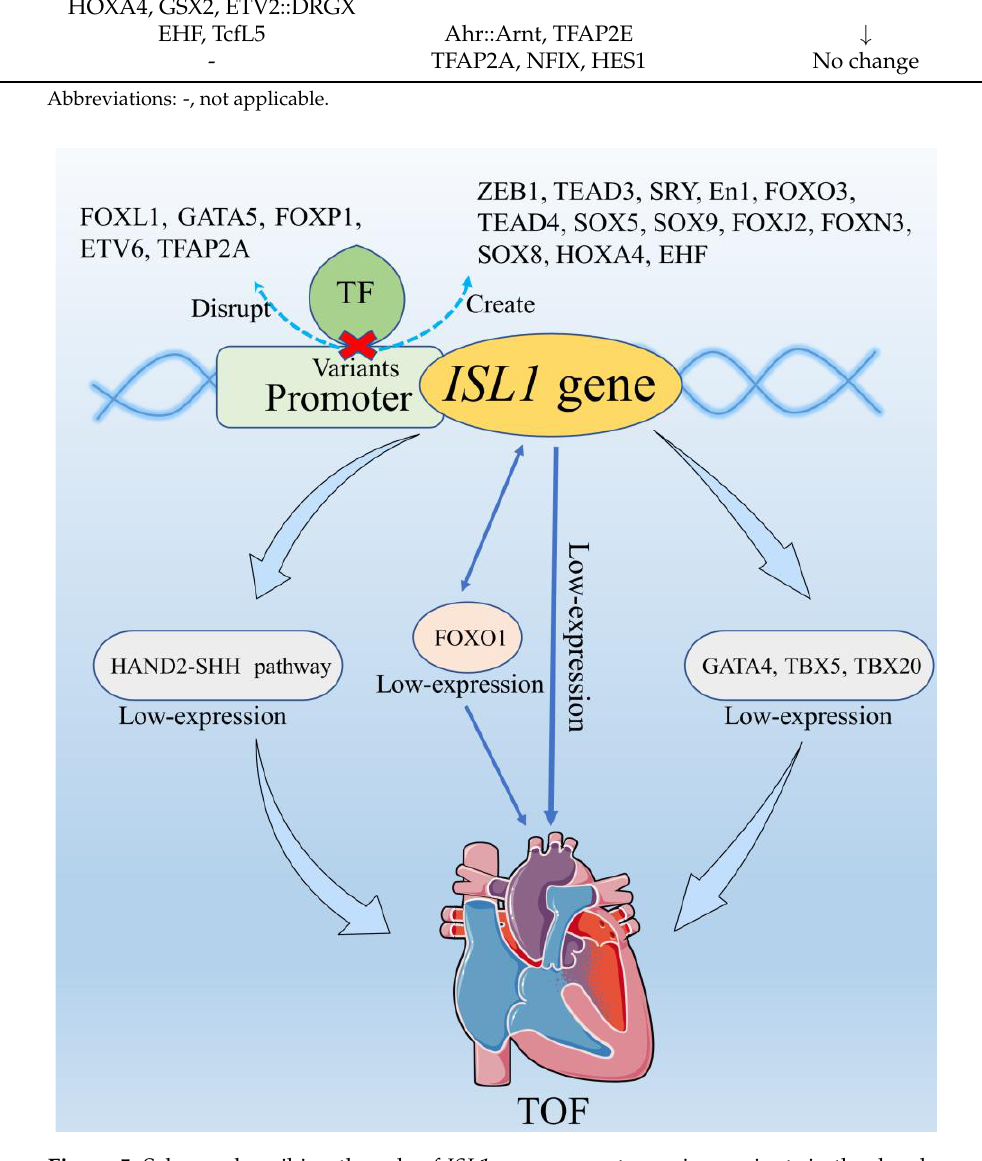
Figure 5. Schema describing the role of ISL1 gene promoter region variants in the development of cardiac defect based on the results from the present study, the JASPAR database analysis, and the previous reports. Variants reduced ISL1 gene promoter activity by disrupting and creating the TFBS (total of 32 [see Table 3]; 18 of them are involved in the heart development that are listed in the figure), contributing to the low expression of ISL1 . Consequently, the low expression of ISL1 may be directly involved in the formation of TOF and may reduce the expression of downstream target genes and pathway, which are related to the formation of